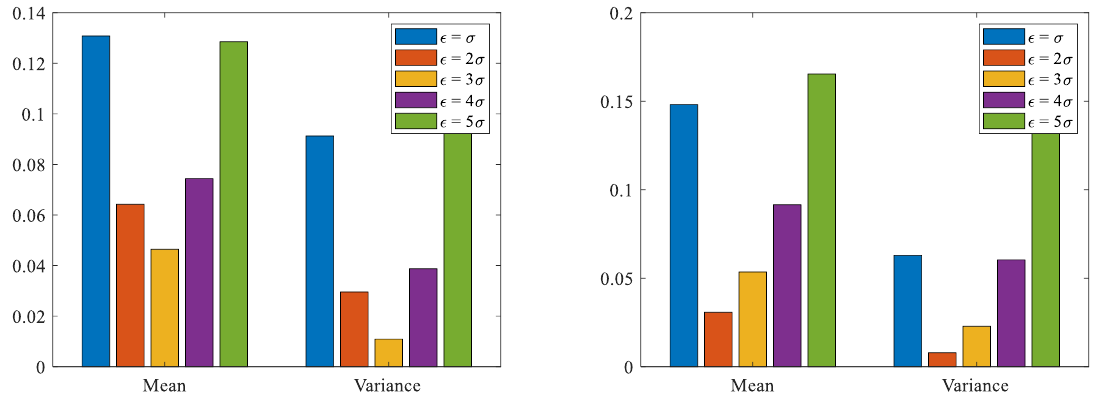
Figure 4. Error comparison of limit reliability boundary with different interception spacings.